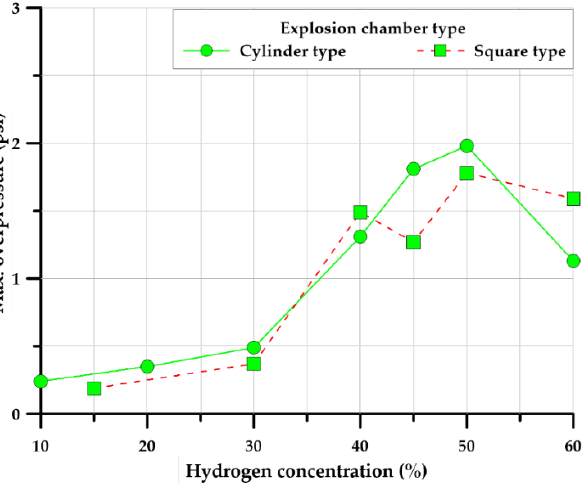
Figure 6. Maximum overpressure concentration by hydrogen (cylinder-, square-type).